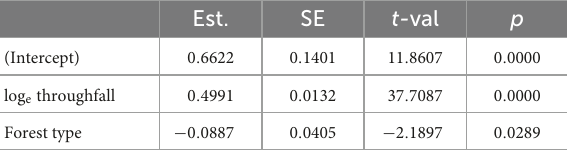
TABLE 1 Regression output of the multivariate mixed model